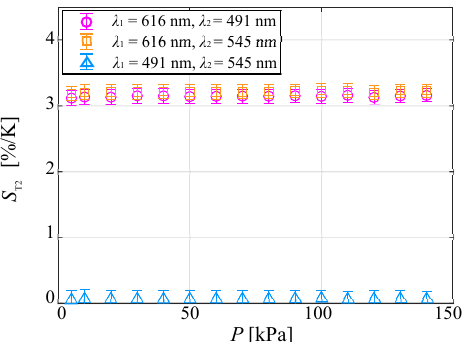
Figure 10. Temperature sensitivity plotted as a function of the ambient pressure.